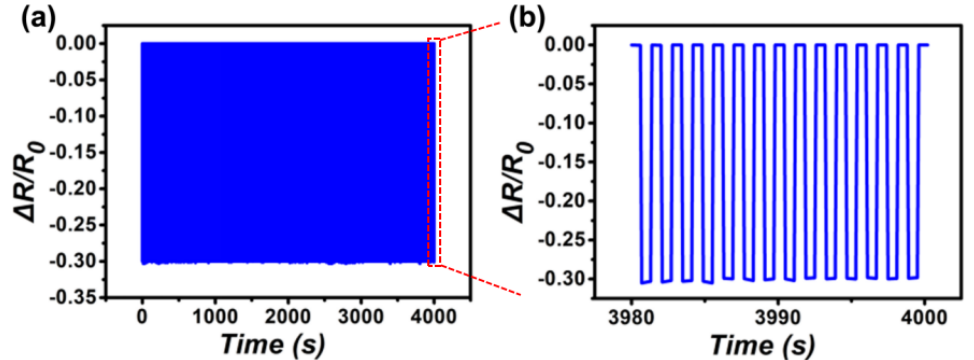
Figure 6. ( a ) Relative resistance change of the sensor when 2800 cycles of loading/unloading are performed at 1 kPa external pressure; ( b ) the 14 cyclic tests extracted from the red region in ( a